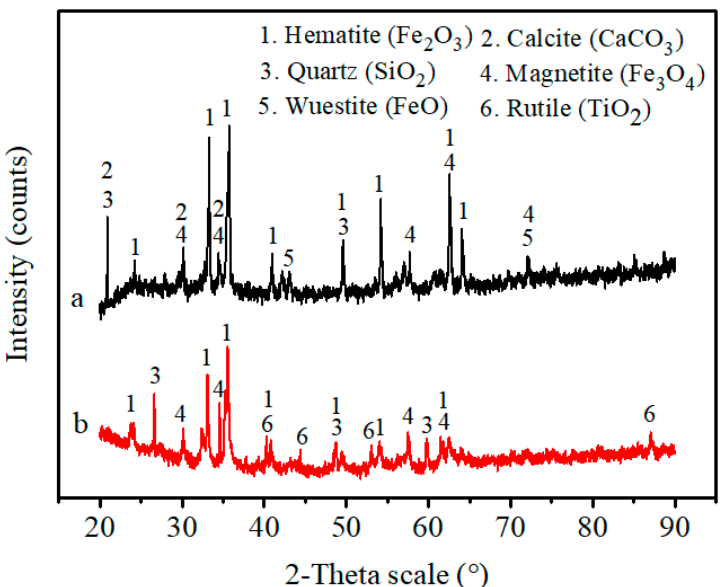
Table 1. Particle size distribution of samples A and B (wt.%).